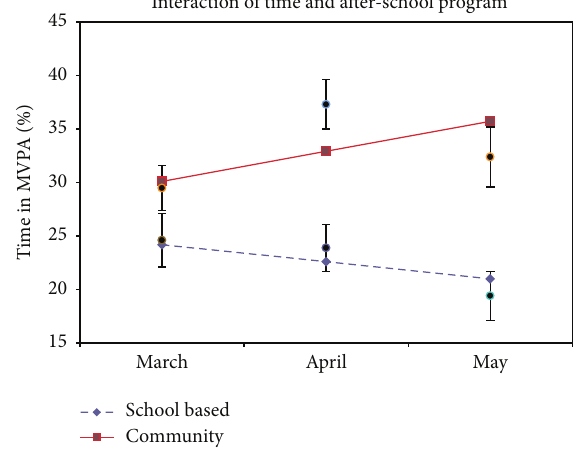
Figure 1: Percent of time spent in physical activity (LMVPA) after- school. Notes: lines show mixed model outcome slopes; points show observed means ± standard error.